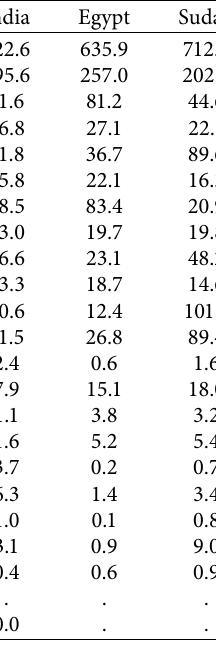
Table 4: Demographic mortality statistics in different countries.